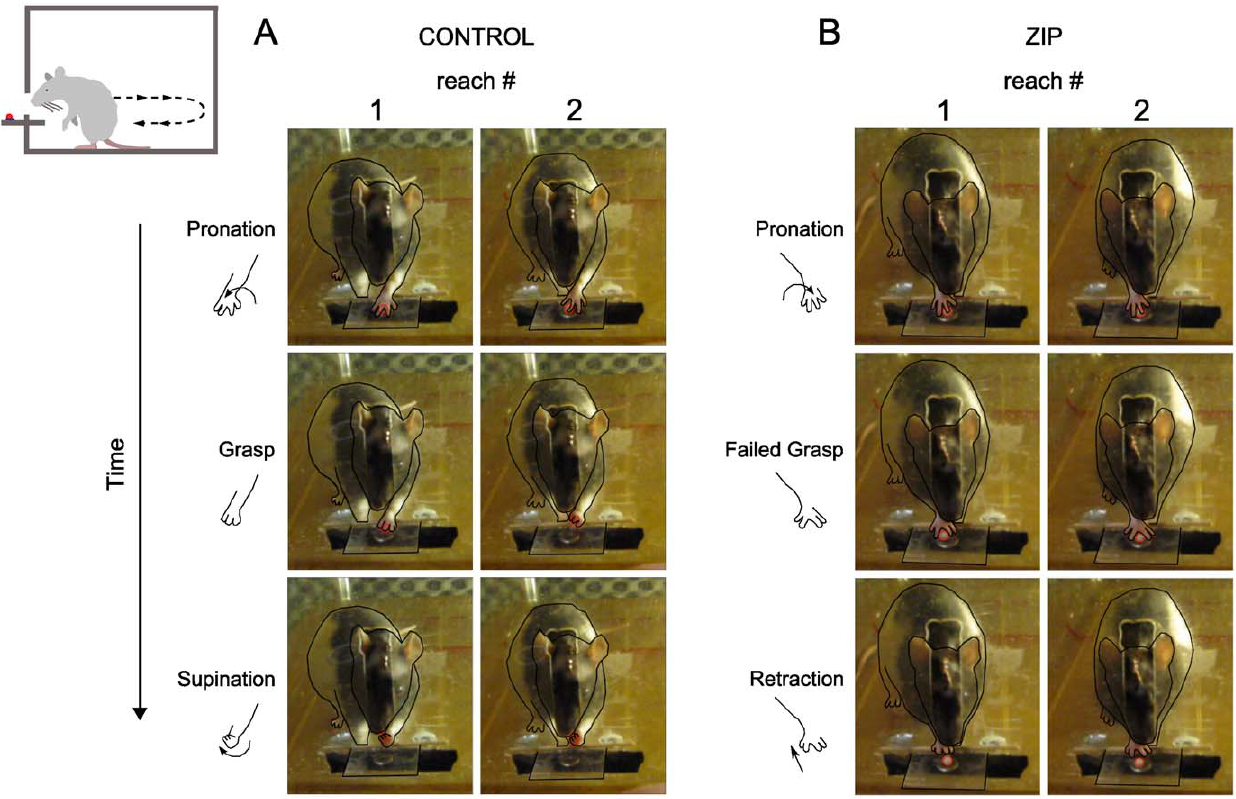
Figure 1. Representative video clips of rats performing reaching behavior after injections of ZIP and saline control into the sensorimotor cortex. Both A) saline and B) ZIP-injected animals first sniff, then pronate their arm in preparation for grasp; the ZIP-injected rat had difficulty in the grasping phase. The rat’s body and limbs are outlined to aid viewing relevant features. Insert above left shows illustration of the reaching task, including reach and subsequent stance reset (dashed arrows).